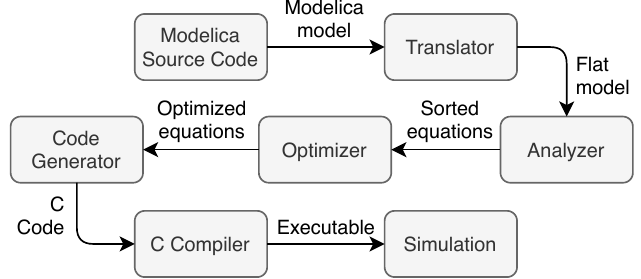
Figure 1. Simulation generation by